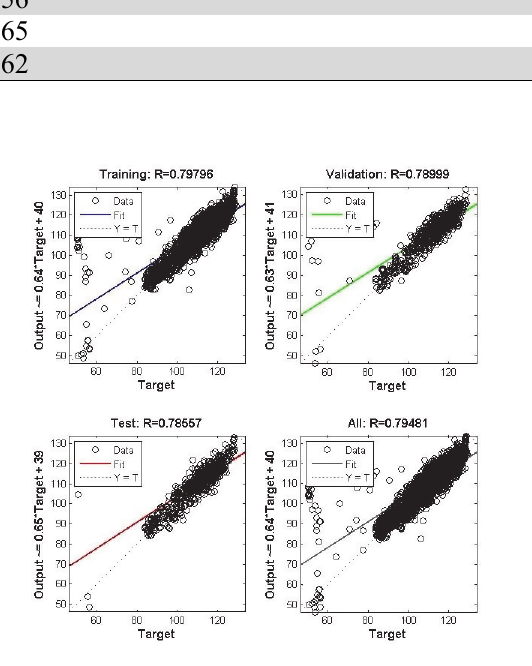
Fig. 9. performance of ST model Fig. 10. Regression diagrams of ST